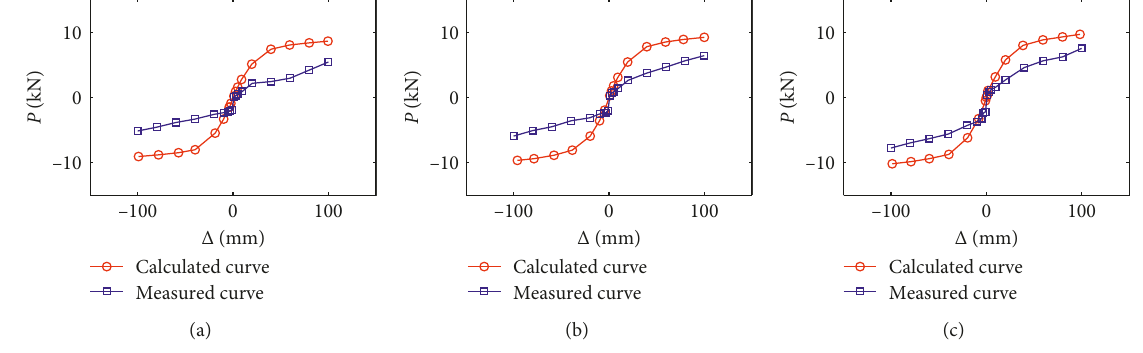
Figure 16: Comparison of experimentally determined and numerically simulated skeleton curves for circumferential column foot damage (ZGW). (a) ZGW133. (b) ZGW163. (c)